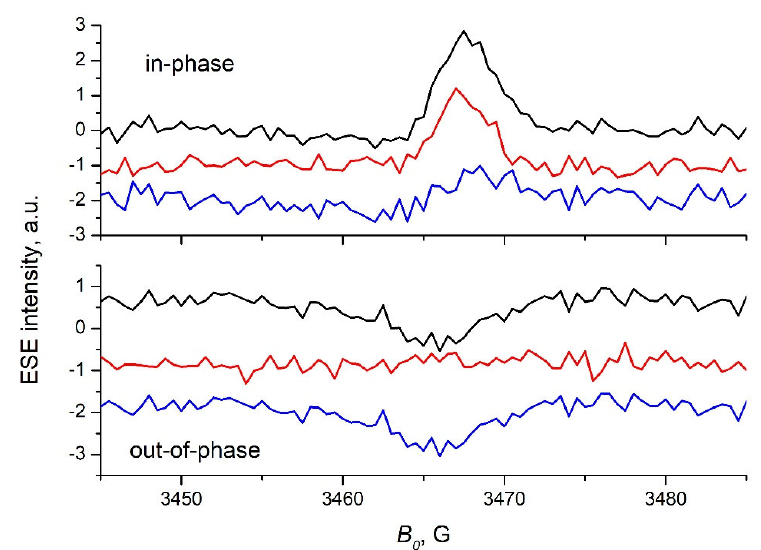
Figure 2. The echo-detected EPR spectra of the P3HT/s-SWCNT composite film taken at 30 K under pulsed laser illumination with delay after flash 200 ns (black lines), without synchronization of laser and microwave pulses (red lines) and their difference (blue lines). Upper panel—the in-phase component of ESE; lower panel—the out ‐ of ‐ phase component of ESE.